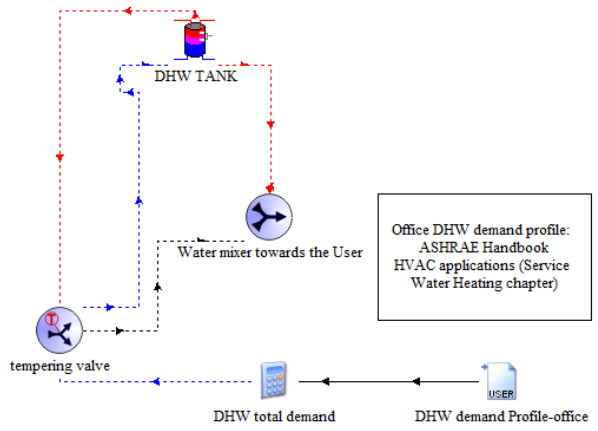
Figure 3. DHW loop macro [30].